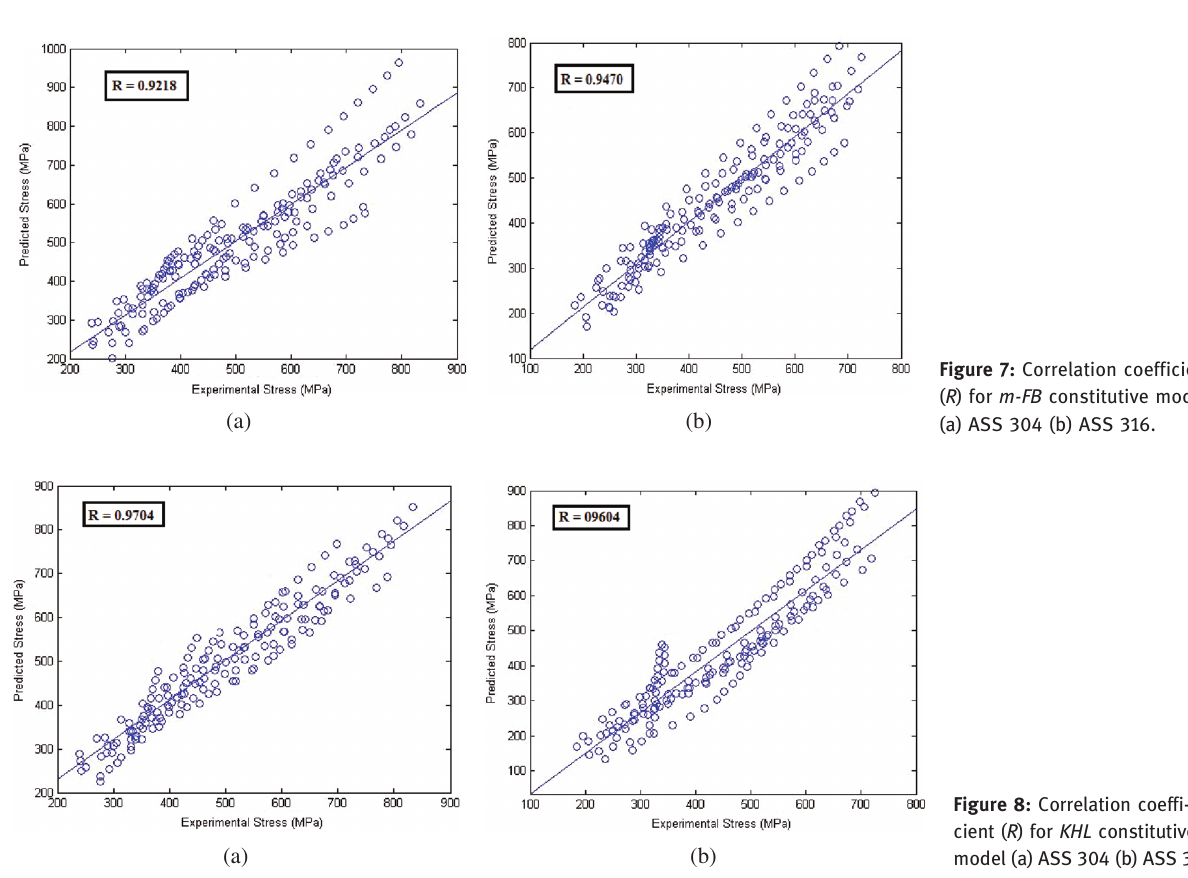
Figure 8: Correlation coeffi- cient ( R ) for KHL constitutive model (a) ASS 304 (b) ASS 316.